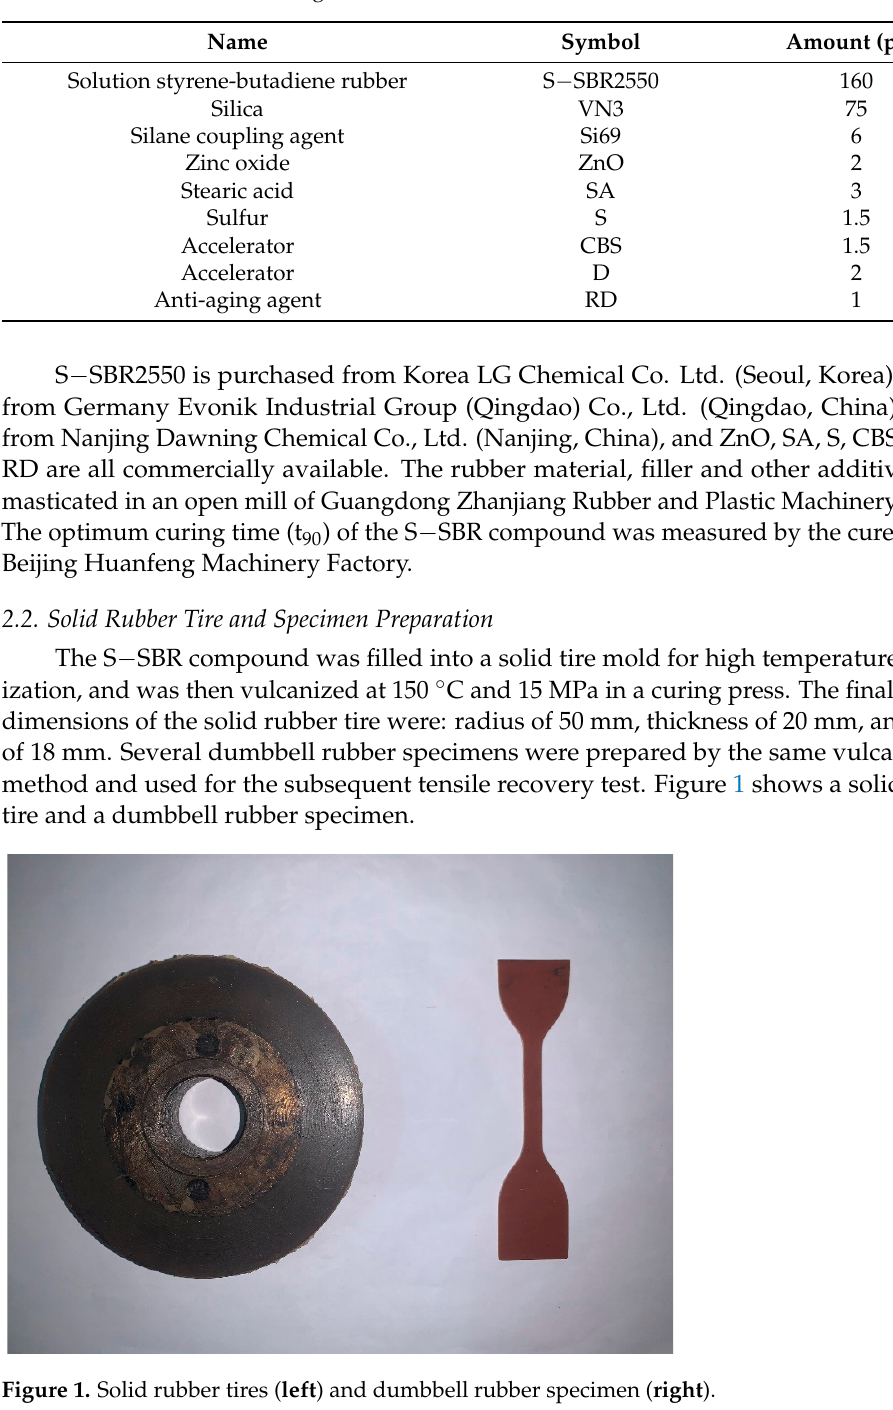
Table 1. Rubber formula of the green solid tire.